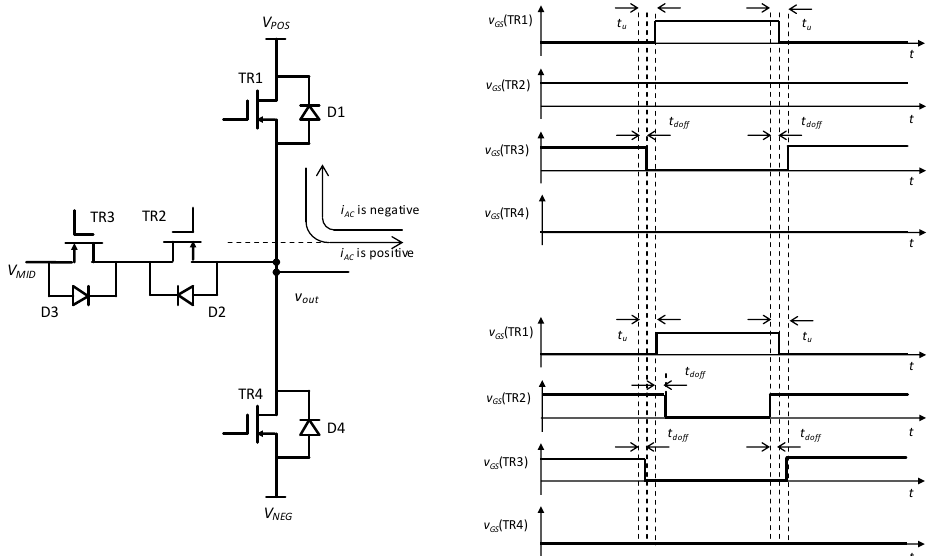
Figure 5. Waveforms. The upper four show the standard drive signals applied when switching between V POS and V MID in a three-level bridge-leg. The lower four show the signals applied using the proposed scheme. TR2 has to be turned on when TR1 is off to clamp v out to V MID and prevent it from making excursions to V NEG whenever i AC is positive.